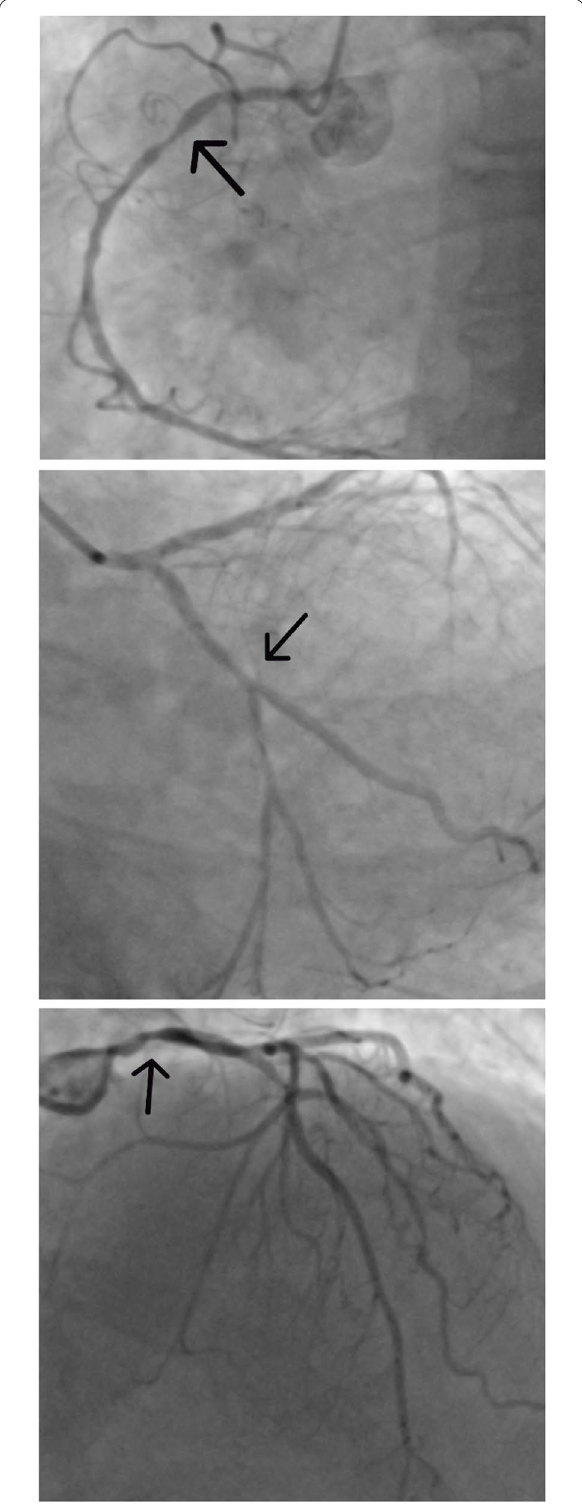
Fig. 2 Coronary disease documented with angiography. The arrows indicate significant coronary